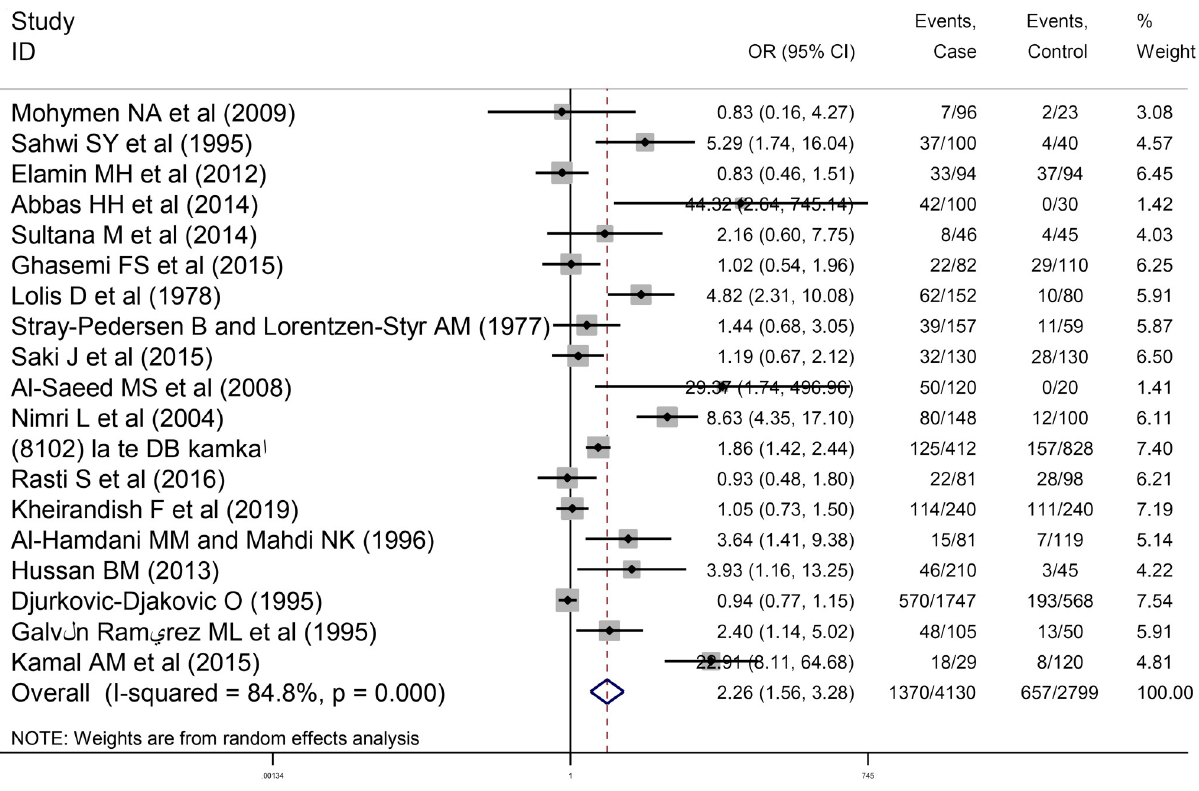
Fig 5. Forest plot diagram of case-control studies showing IgG seropositivity rates of T . gondii .